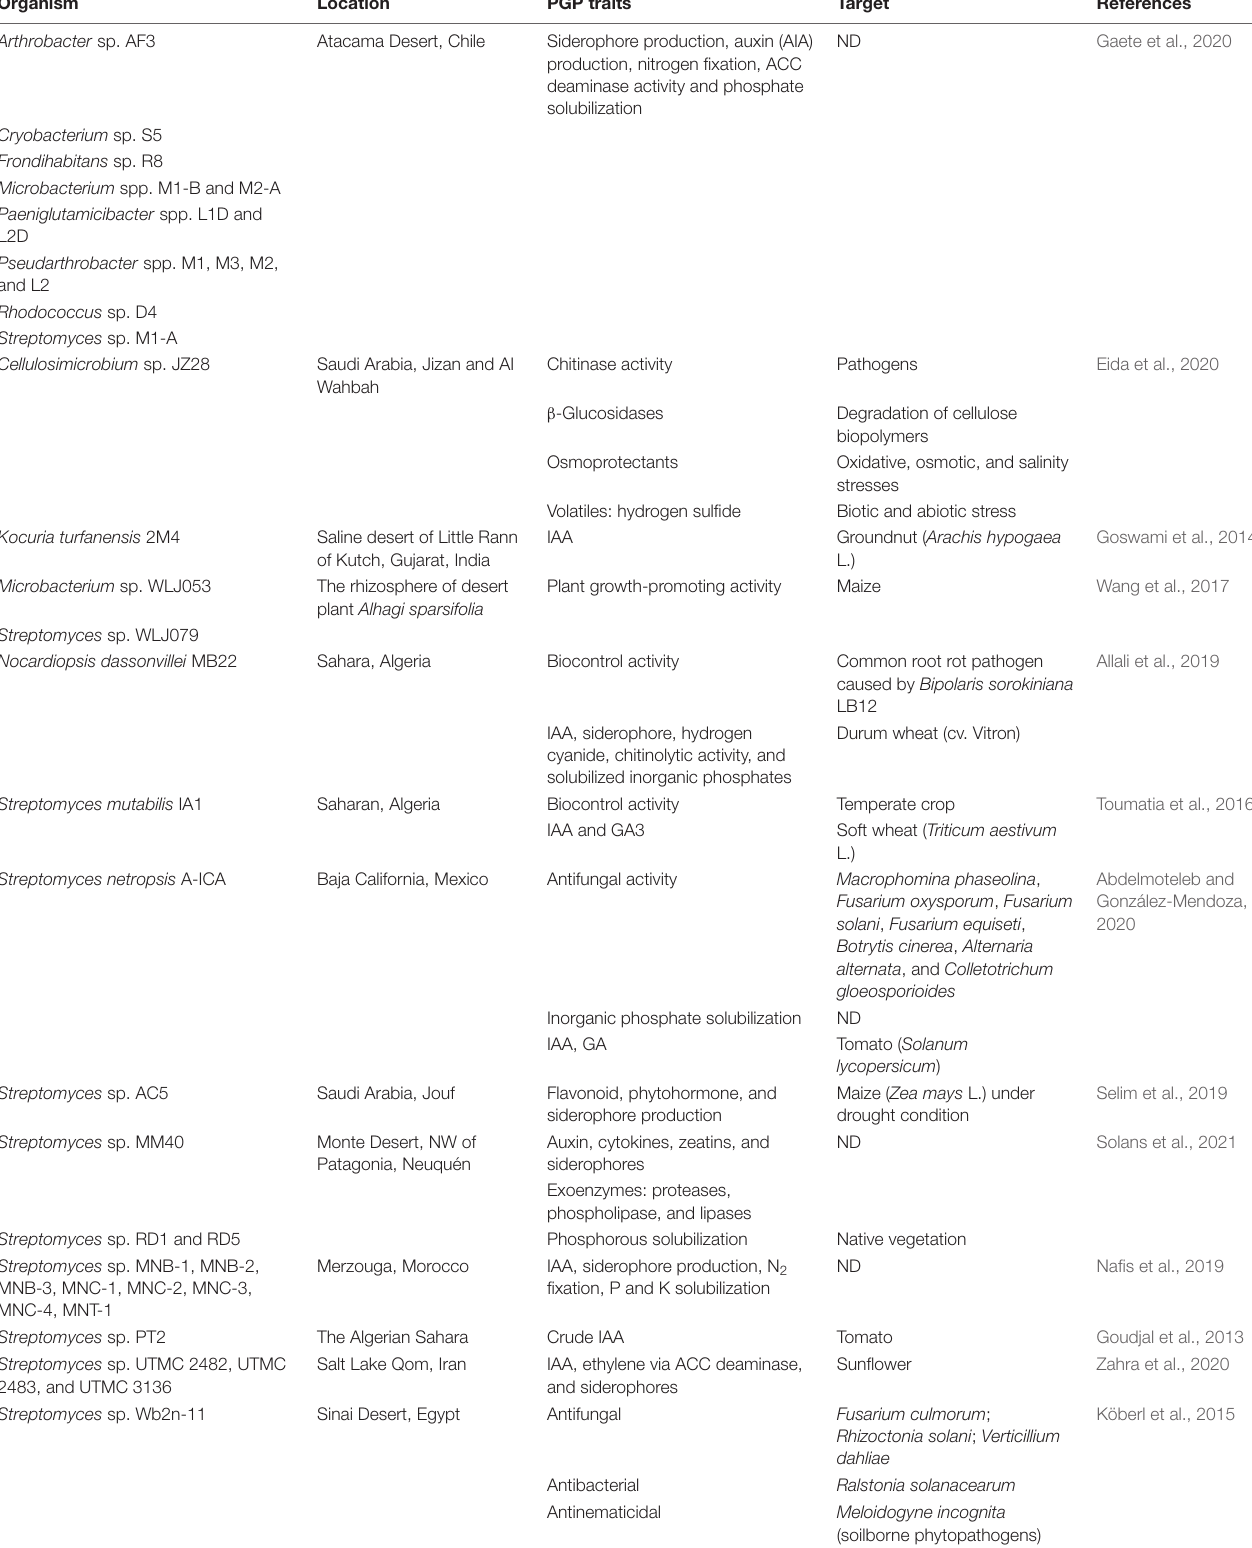
TABLE 4 | Agricultural applications from desert actinobacteria between 2000 and